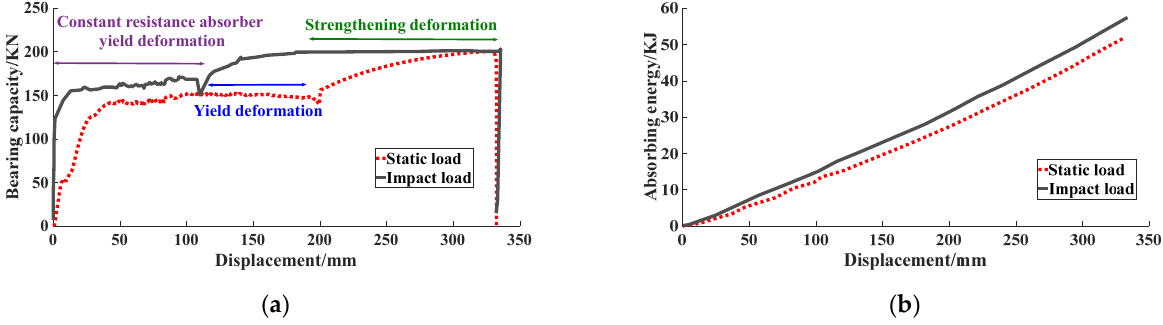
Figure 11. Mechanical property curves of energy absorbing anchor rods ( a ) Bearing capacity-displacement curve; ( b ) Energy absorption characteristic curve. Table 5. Comparison of mechanical properties of energy absorbing anchor.